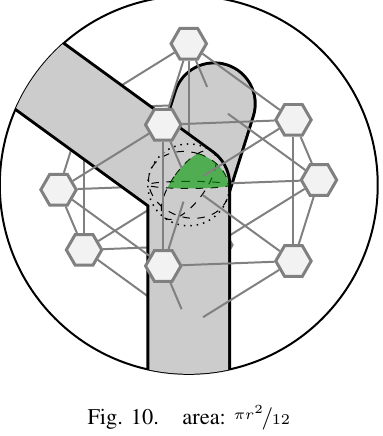
Fig. 10. area: πr 2 /